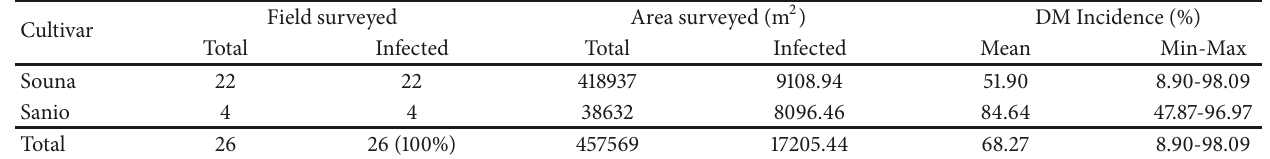
Figure 6: Map showing downy mildew incidence across surveyed field in Senegal during rainy season 2017. Table 2: Prevalence of downy mildew on cultivars across pearl millet production